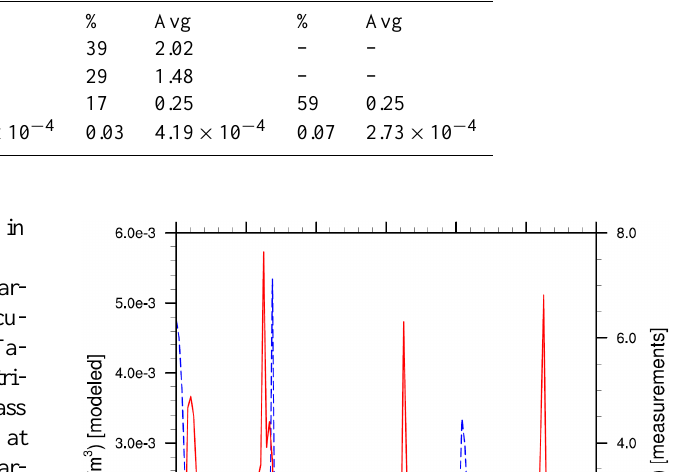
Table 5. Estimated contribution of Tula flaring activities to SO 2 and soot levels at MILAGRO supersites. SO 2 units areppb and soot units are µgm − 3 . TIC includes Francisco Perez Rios Power Plant (FPRPP) and Miguel Hidalgo Refinery (MHR). Pollutant